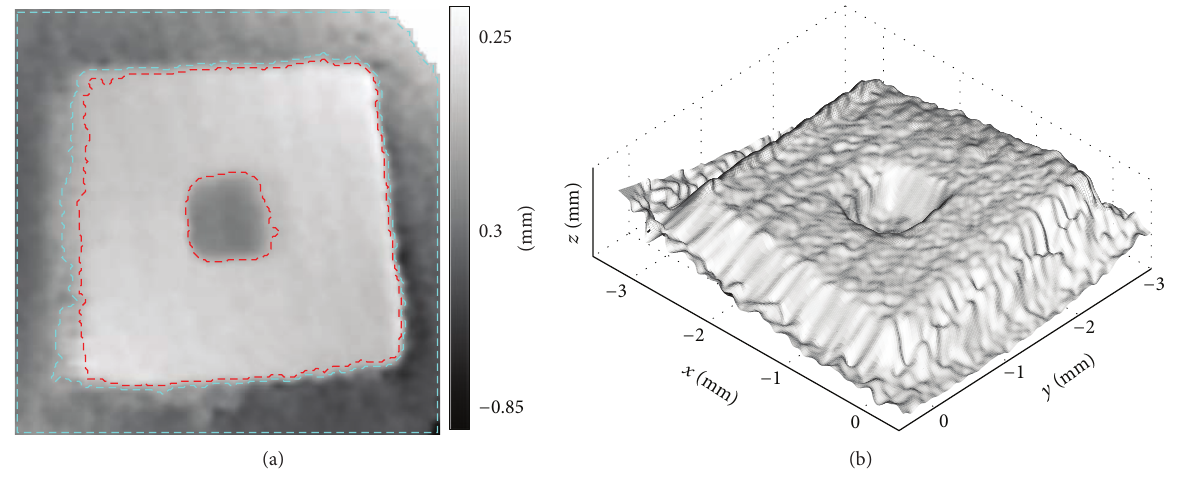
Figure 12: The gross tilt is removed from Figure